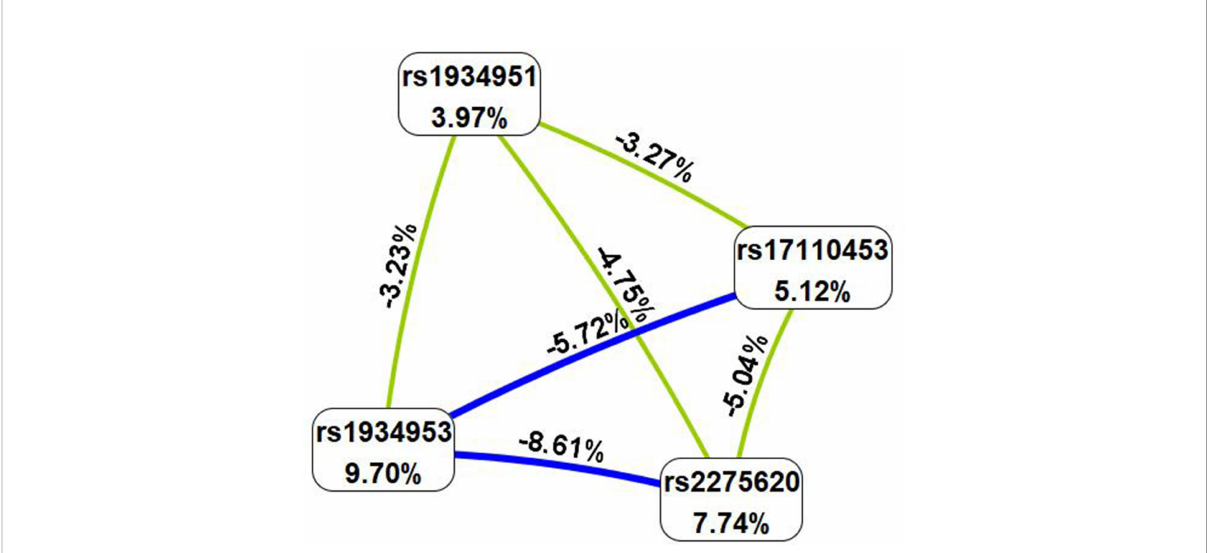
FIGURE 1 SNP – SNP interaction map. Values in nodes represent the information gains of individual attribute (main effects). Values between nodes are information gains of each pair of attributes (interaction effects). Blue and green with negative percent entropy indicate redundancy or independence.